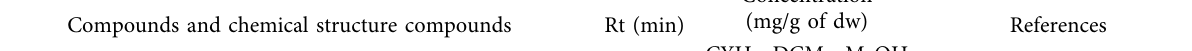
Table 3: Phenolic compounds contents identified in various extracts of R. crispus aerial parts by HPLC-DAD. N ° Compounds and chemical structure